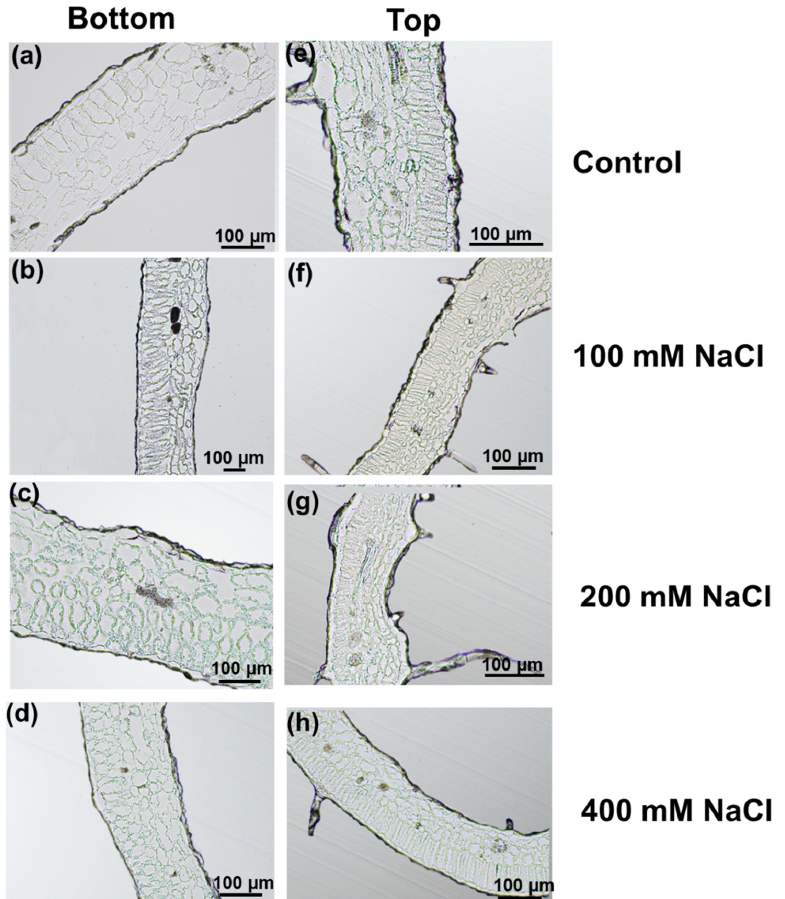
Figure 5. Microtome sections of bottom ( a – d ) and top ( e – h ) leaflets of Micro-Tom plants under control conditions and exposed to 100 mM, 200 mM, 400 mM NaCl. The palisade and spongy layers are shown.